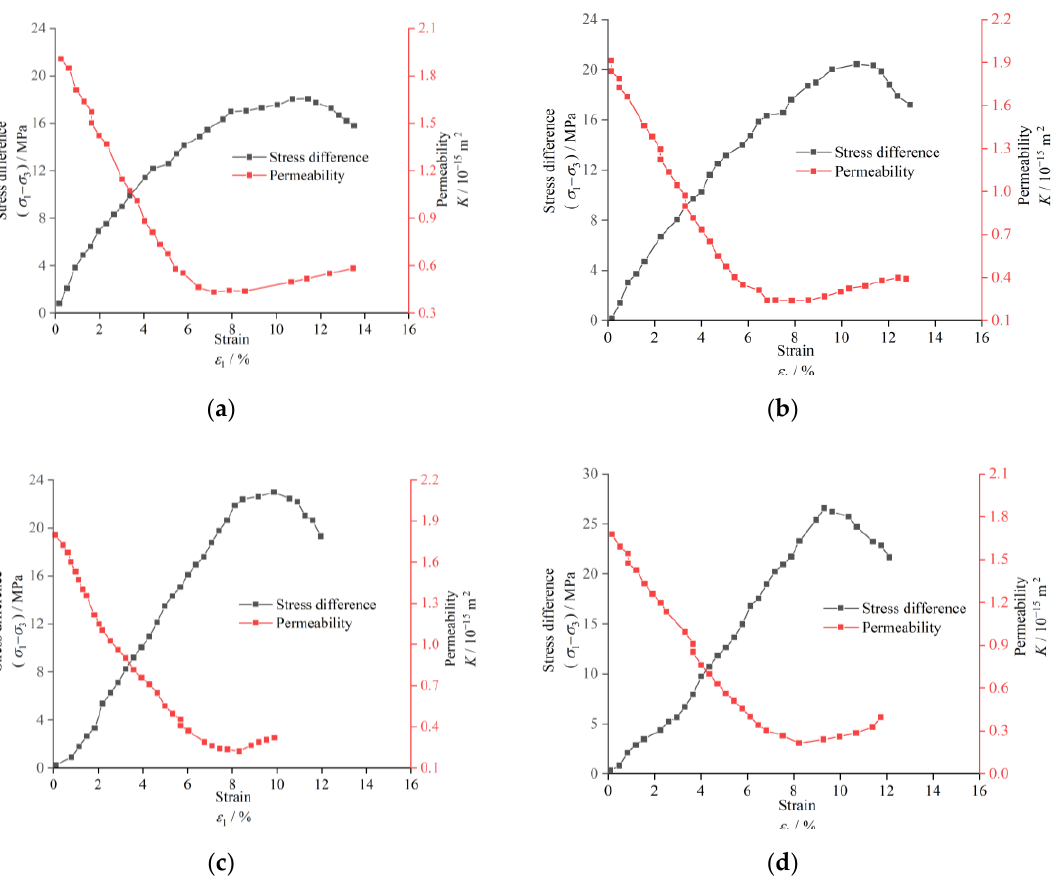
Figure 7. Curves of stress, permeability, and strain under axial compression of coal samples with a constant gas pressure of 1.5 MPa and different confining pressures. ( a ) σ 2 = σ 3 = 4 MPa, ( b ) σ 2 = σ 3 = 5 MPa, ( c ) σ 2 = σ 3 = 6 MPa, ( d ) σ 2 = σ 3 = 7